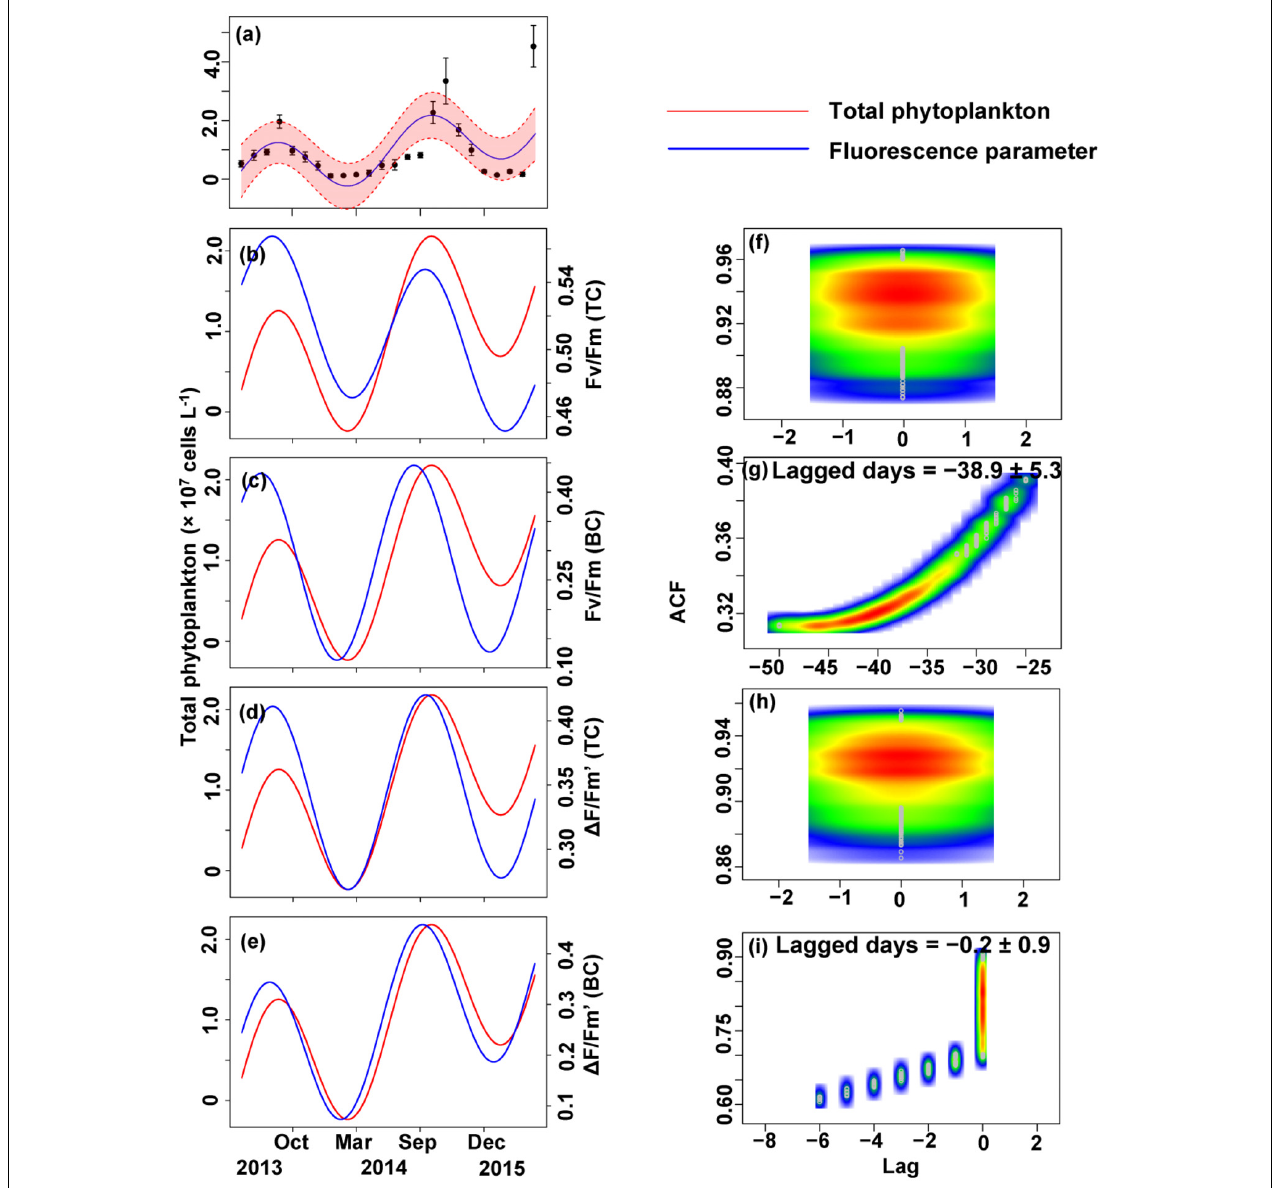
FIGURE 6 | Trigonometric regression of the total phytoplankton cell density ( × 10 7 cells L − 1 ) (a) and fluorescence measurements [ F v / F m (TC) (b) , F v / F m (BC) (c) , (cid:49) F / F m (cid:48) (TC) (d), and (cid:49) F / F m (cid:48) (BC) (e) ]. We fitted these seasonal trends with a time-lag analysis [ F v / F m (TC) (f) , F v / F m (BC) (g) , (cid:49) F / F m (cid:48) (TC) (h) , and (cid:49) F / F m (cid:48) (BC) (i) ]. The legged days and associated standard deviation among sites is shown in each